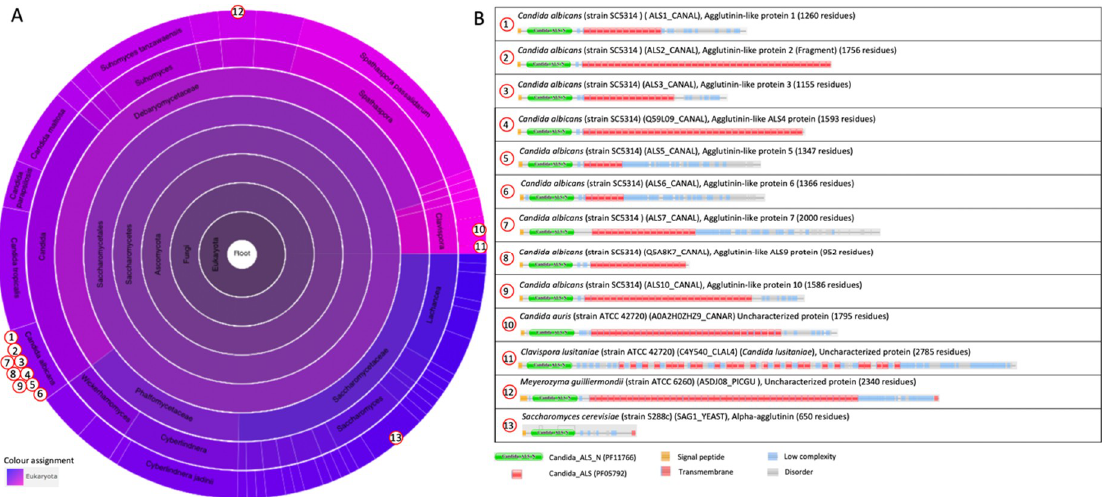
Figure 4. The domain family “Cell‐wall agglutinin N‐terminal